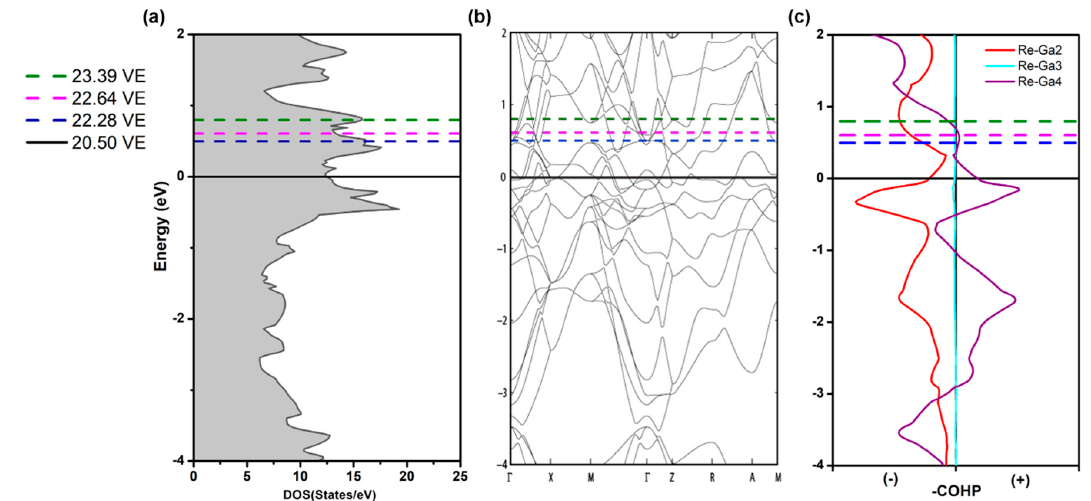
Figure 4. Electronic structure calculations with a black solid line indicating the Fermi level for theoretical ReGa 4.5 and a dashed blue, pink and green line indicating the Fermi energy level for ReGa 4.96 (Sn), ReGa 5.08 (Pb) and ReGa 5.13 (Bi), respectively, for the ( a ) density of states (DOS) curves, obtained from Local-Density Approximation (LDA), ( b ) band structure and ( c ) Orbital Hamiltonian Population Curves (COHP), for Re-Ga interactions.